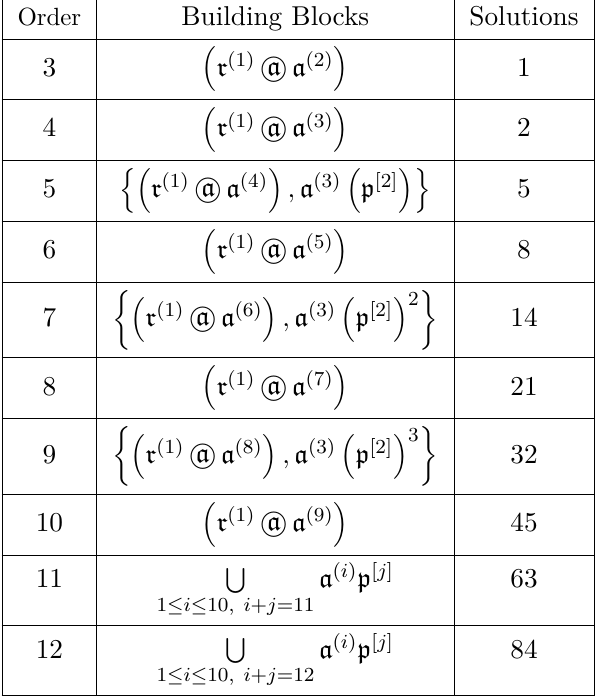
Table 2 . Total number of linearly-independent adjoint numerator scalar solutions at each order in momentum